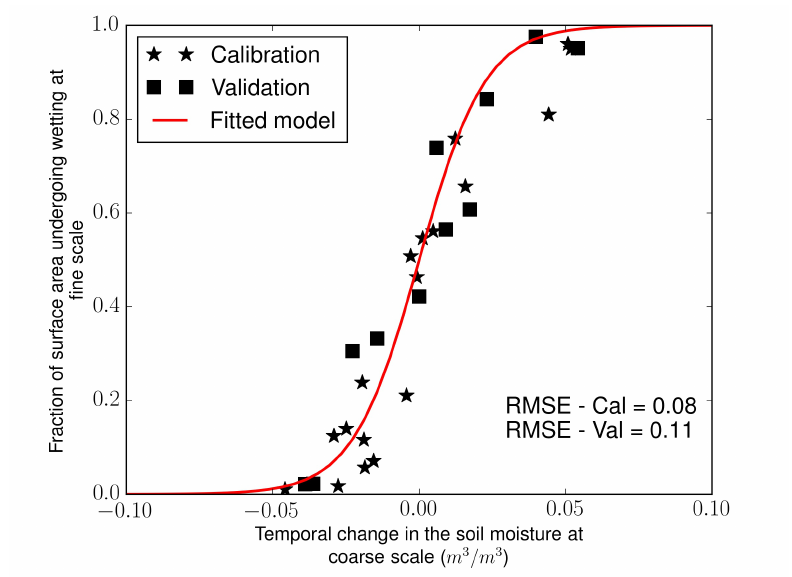
Figure 10. Computed and observed F wet (fraction of surface area undergoing wetting at fine scale) at a spatial resolution of 1000 m from the retrieved RADARSAT-2 soil moisture as a function of the change in the soil moisture at coarse scale.